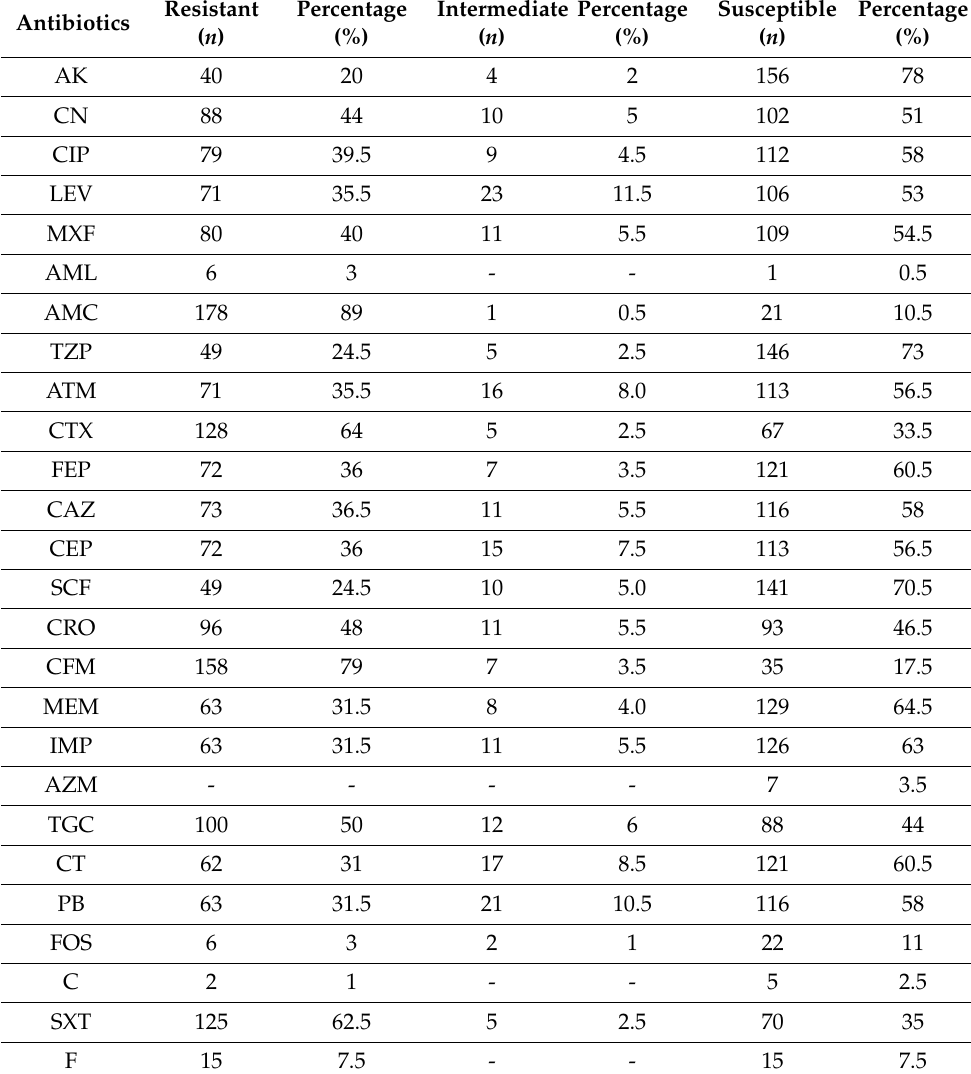
Table 5. Antibiotic susceptibility pattern of P. aeruginosa